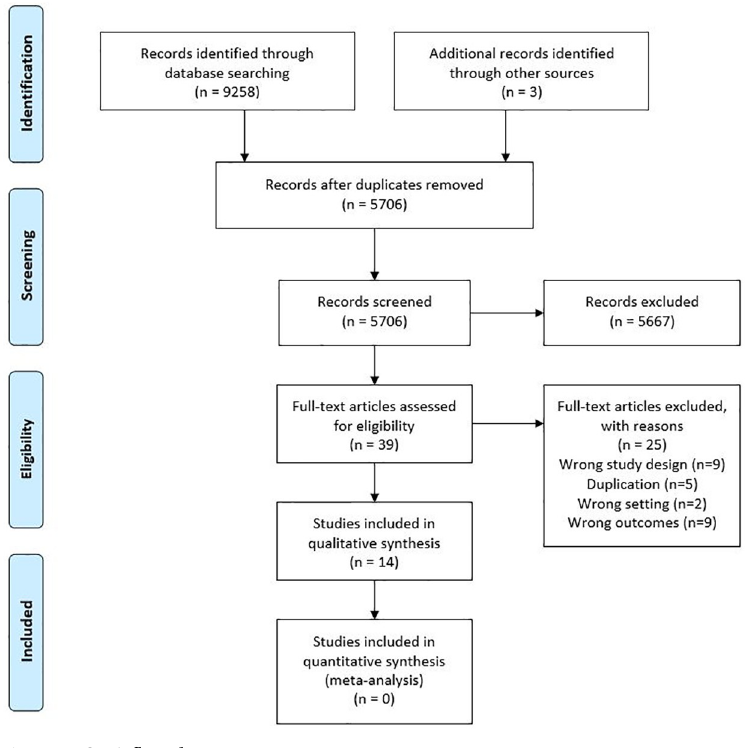
Fig 1. PRISMA flow